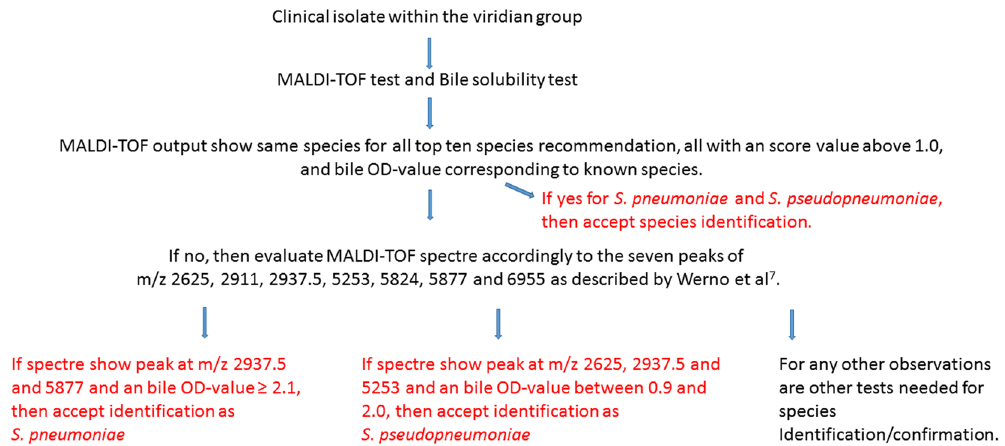
Figure 2. A description of species identification based on MALDI-TOF and Bile solubility test for clinical isolates from the mitis